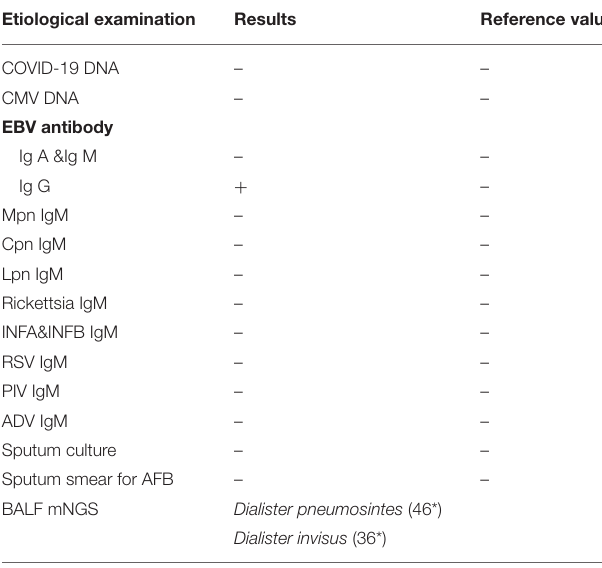
TABLE 2 | Etiological examination